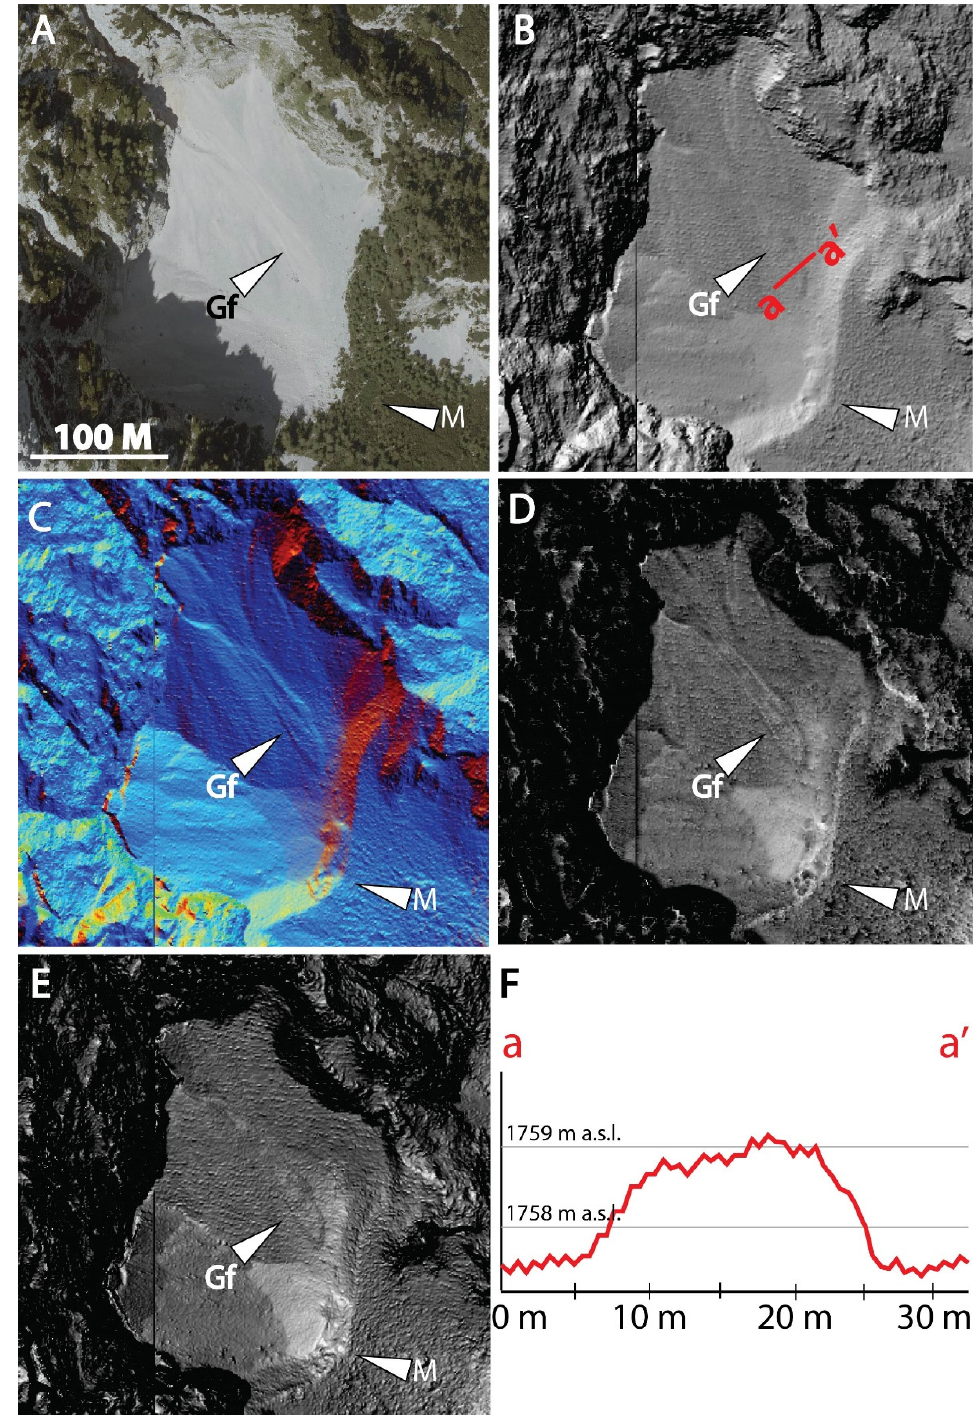
Figure 8. Moraine ridge (M) and grain flow deposit (Gf) on a scree deposit. ( A ) Aerial photograph, ( B ) analytical hillshading (H315, A35), ( C ) hillshading from multiple directions RGB (D16, H35), ( D ) 8-bit sky view factor and ( E ) 8-bit slope visualisations, ( F ) topographic profile (a–a’) over the distal part of the grain flow deposit. For location see rectangle 8 in Figure 1.